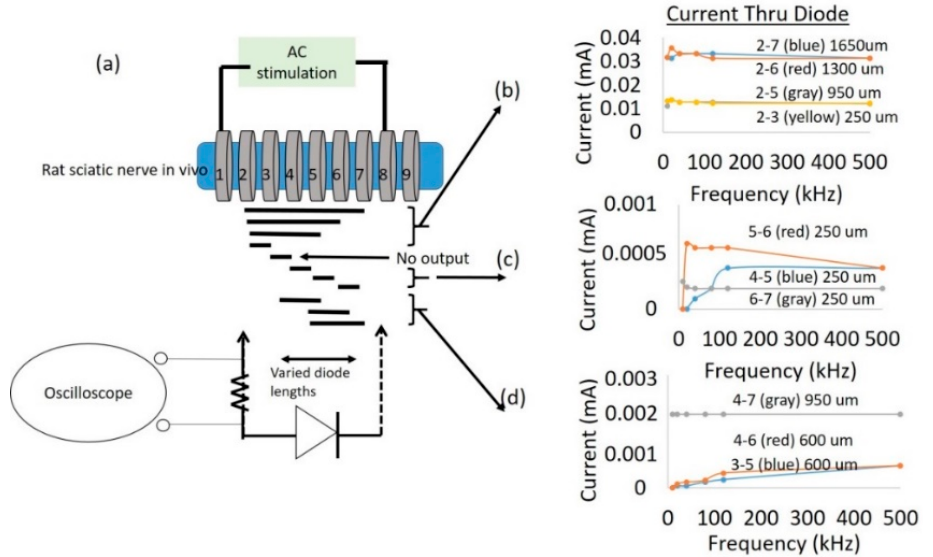
Figure 10. Typical current measurements through the diode for different diode lengths and positions for a 1 V (peak-to-peak amplitude) AC drive voltage. The experimental setup and the different diode lengths and positions that were tested are shown in ( a ). The diode was externally attached to different cuff leads as indicated to emulate different diode length and position relative to stimulating electrodes. ( b ) Larger diode–dipole lengths and placement within 250 µm of a stimulating AC electrode resulted in larger measured currents. ( c ) Shorter diode–dipole lengths of 250 µ m and placement >250 µ m away from the stimulating electrodes showed 20–60 fold less current through the diode. ( d ) Current measurements for diode–dipole lengths of 600 µ m and 950 µ m and placement >250 µ m away from the stimulating electrodes.